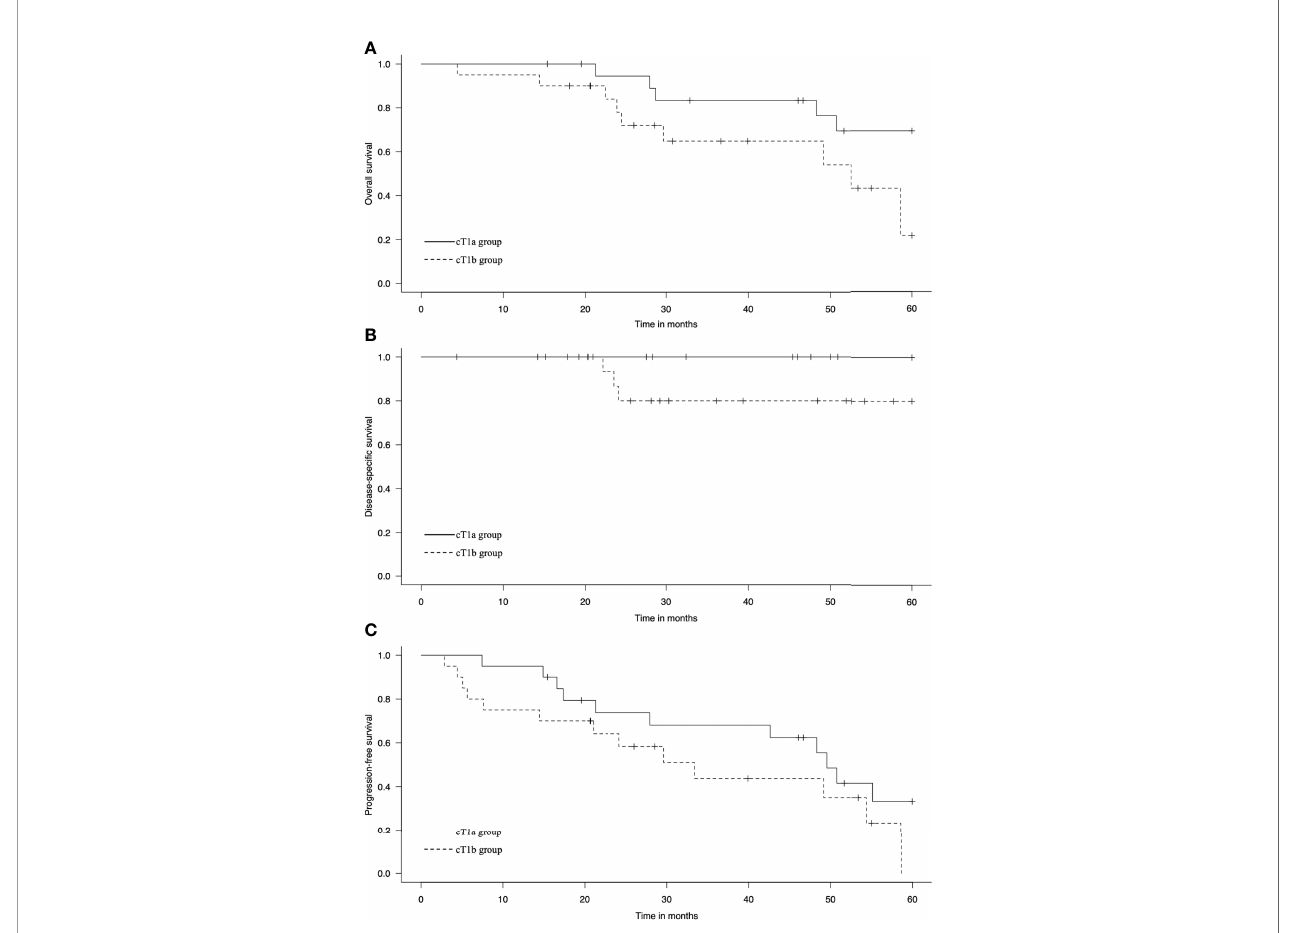
FIGURE 1 | Kaplan – Meier estimates of (A) overall survival, (B) disease-speci fi c survival, and (C) progression-free survival in the cT1a and cT1b